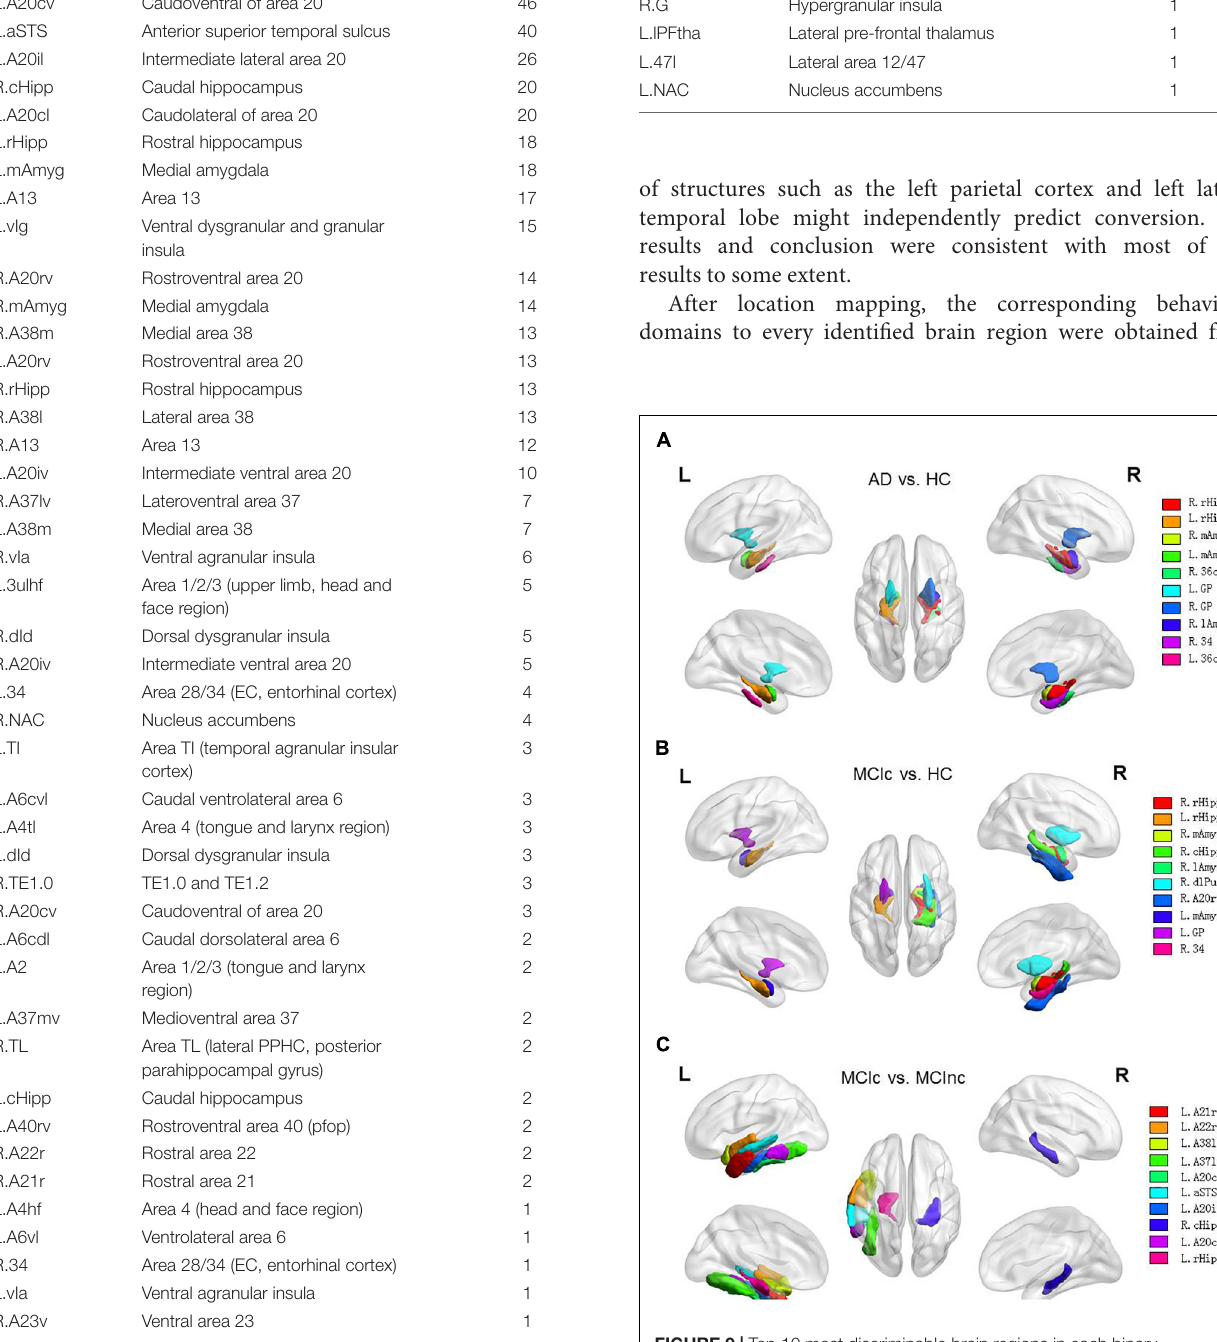
FIGURE 9 | Top 10 most discriminable brain regions in each binary classification task: (A) AD vs. HC; (B) MCIc vs. HC; (C) MCIc vs.